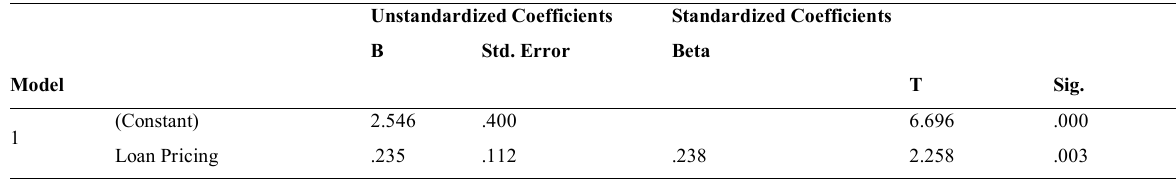
Table 5: Coefficients for Loan Pricing Practices